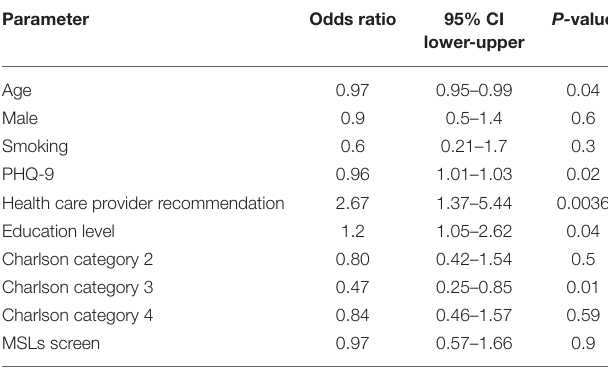
TABLE 3 | Predictors of CR participation.